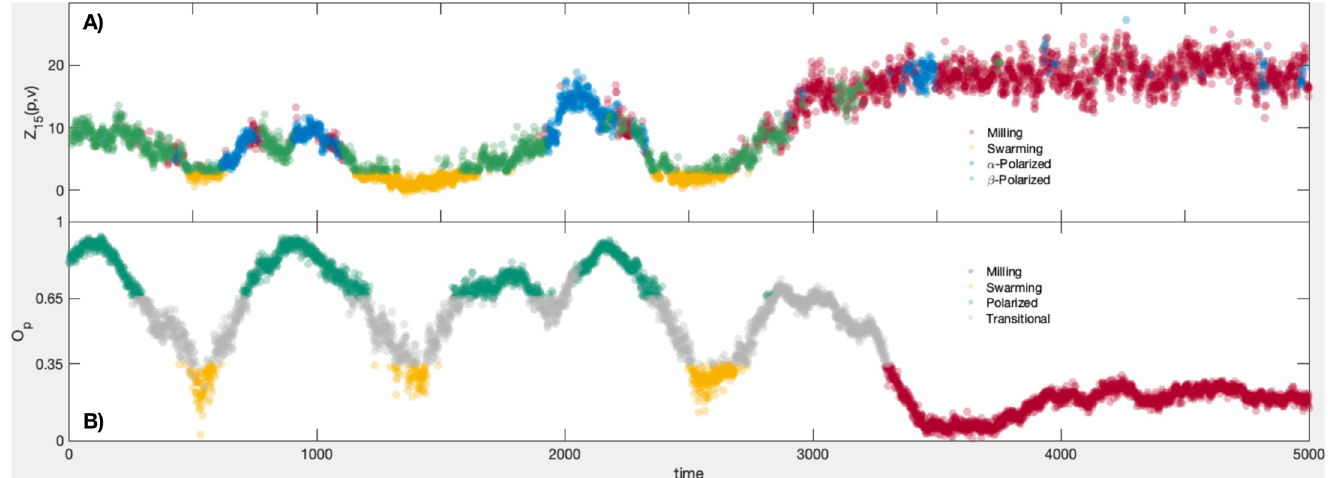
Fig 5. Statistics calculated from 5000 frames of the golden shiner dataset. A): Map alignment Z 15 ( p , v ) calculated over 5000 video frames. The plots are colored according to our classification of macro-scale state; milling = red, swarming = yellow, α -polarized = blue, β -polarized = green. B): The group polarization macro- variable O calculated from the same 5000 frames. The coloring shows the states according to [29]; milling = red, swarming = yellow, polarized = teal, unclassified/ p transitional = grey.